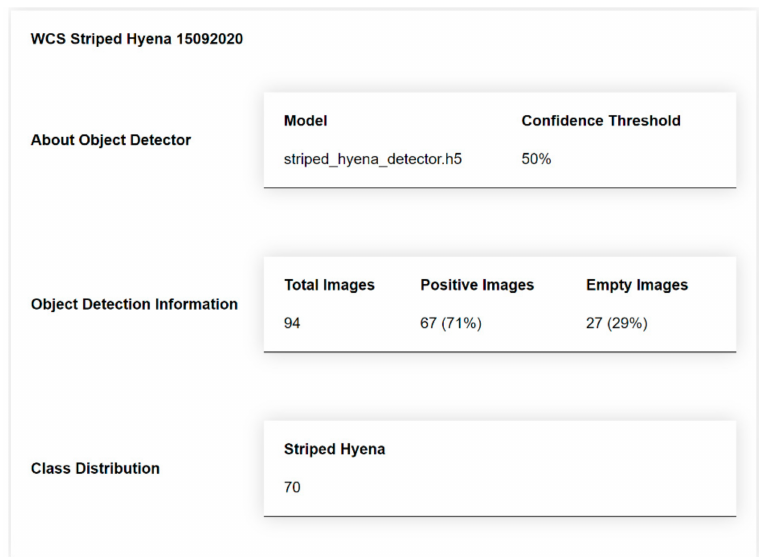
Figure 3. A sample summary report generated by running inference on a dataset of images. The report provides a summary of object detection information, including class distribution, number and percentage of positive images compared to empty